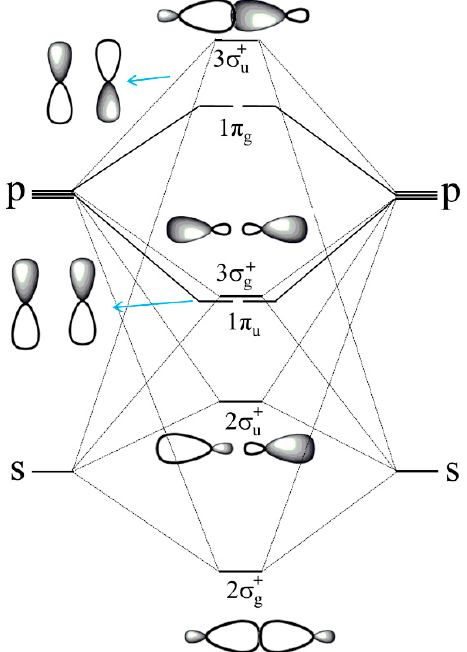
Figure 2. MO correlation diagram of the 2s and 2p AOs of first octal-row atoms.